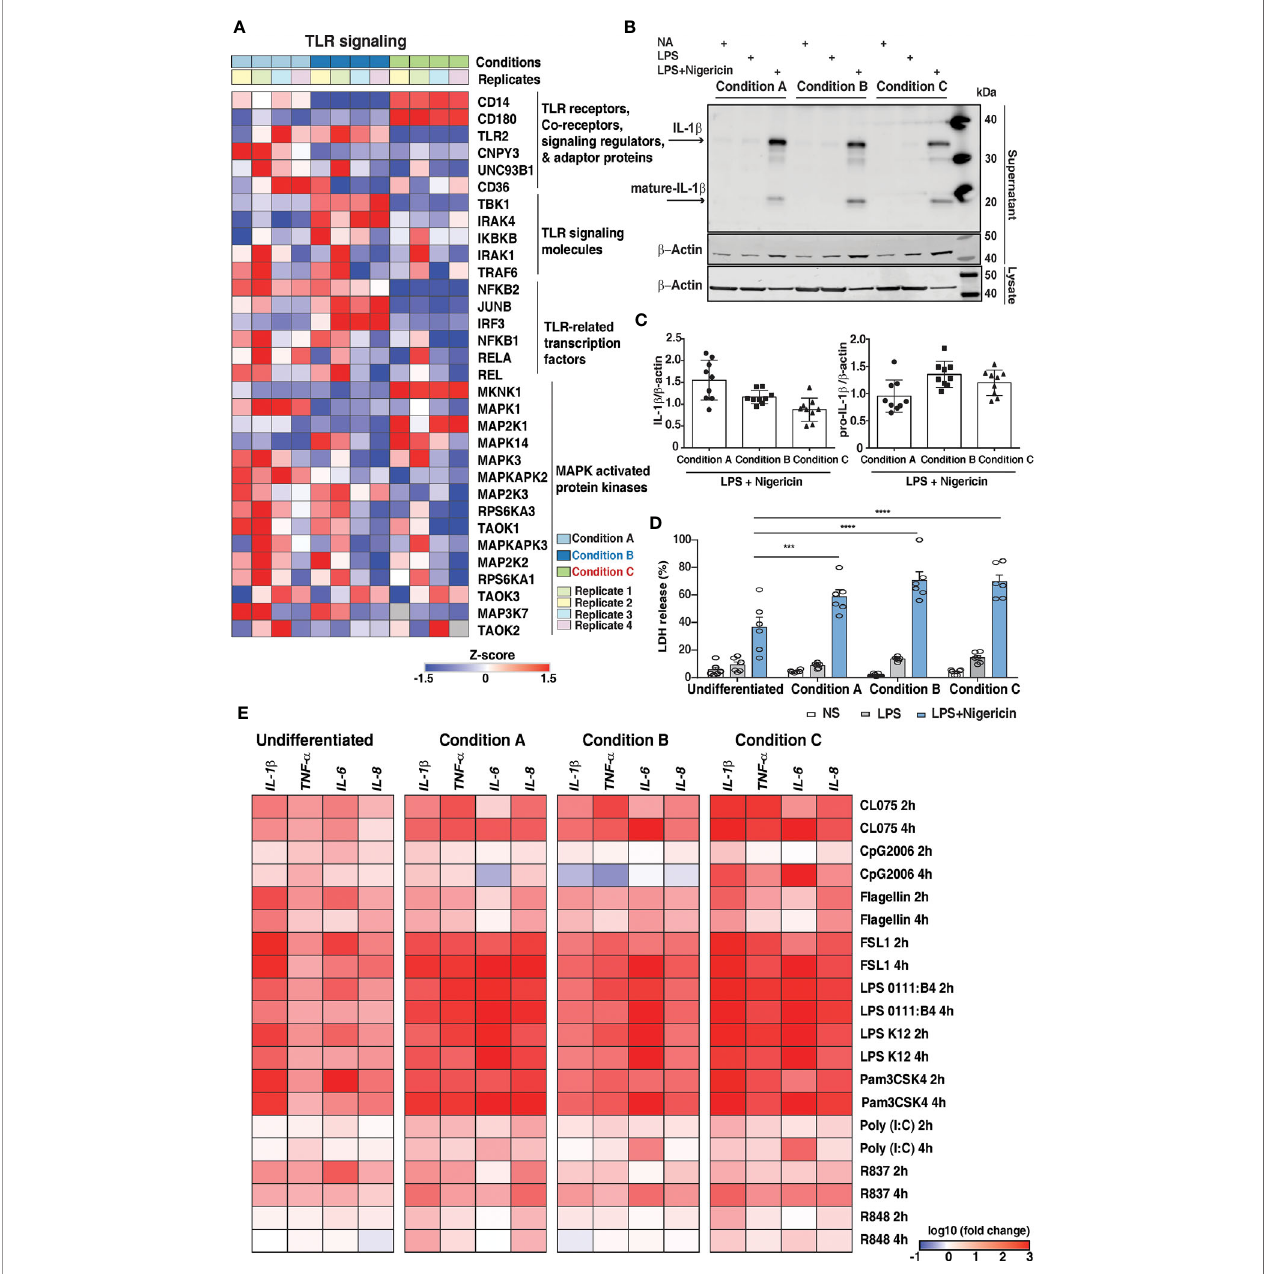
FIGURE 5 | Expression dynamics of genes involved in innate immune signaling in response to PMA. (A) Heatmap demonstrates the proteome fold change of a subset of genes involved in innate immune signaling. The scale indicates the level of expression (Log2-expression values, z-transformed, scaled). (B) Representative image of Immunoblot analysis and (C) quanti fi cation by densitometry of pro- and mature IL-1 b protein in supernatants of PMA differentiated THP1 cells treated with LPS (2h) followed by NLRP3 agonist; nigericin (2h). Blots are representative of 3 independent experiments analyzed in technical triplicates. Data are shown as mean ± SEM (two-tailed Student ’ s t-test) (D) LDH release assay of PMA differentiated THP1 cells (n=6) treated with LPS (2h) followed by NLRP3 agonist; nigericin (2h). (measured as % LDH release of total lysis control). Data are shown as mean ± SEM. ***P 0.0003, ****P<0.0001 by one-way ANOVA with Tukey ’ s multiple-comparisons test (E) Dynamic expression pattern to assess the expression levels of pro-in fl ammatory cytokine mRNA induced by TLR agonists for 2h and 4h: CL075-TLR7/8, CpG2006-TLR9, Flagellin-TLR5, FSL1-TLR2/6, LPS 0111:B4, and LPS K12 – TLR4, Pam3CSK4-TLR2/1, Poly I:C-TLR3, R837-TLR7, and R848-TLR7/8. Heatmap depicts the Log10 fold change of normalized gene expression for pairwise comparisons of mRNA